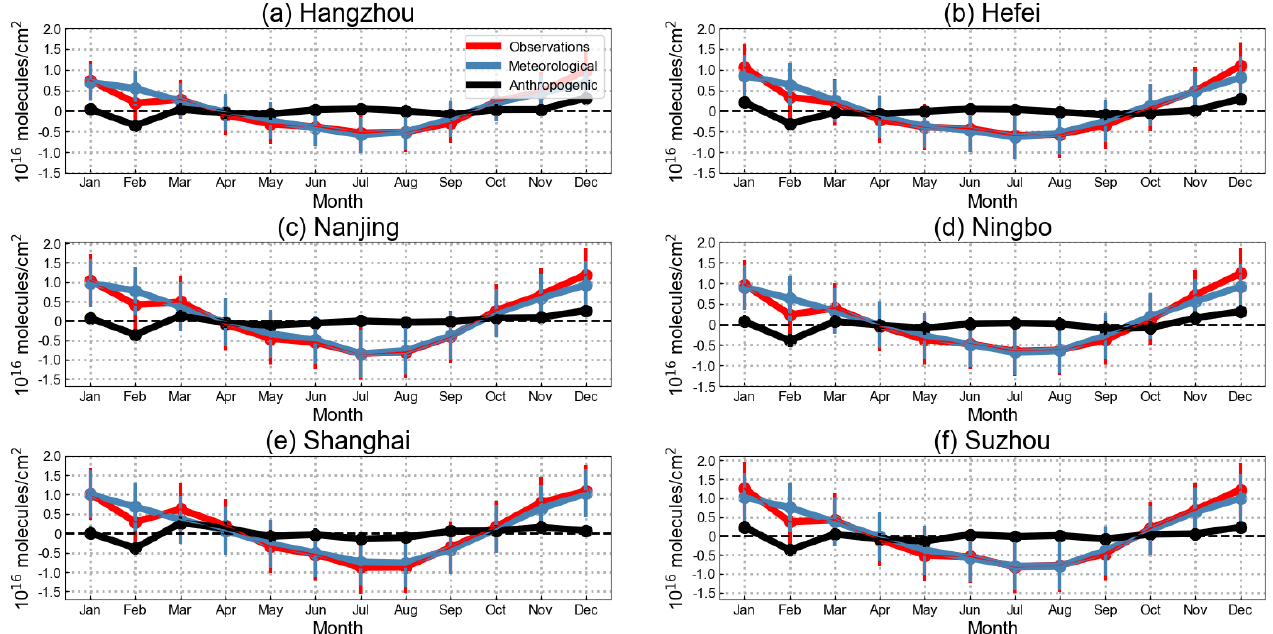
Figure 6. Monthly averaged NO 2 VCD trop (red dots and lines) along with the meteorological-driven portions (blue dots and lines) and the anthropogenic-driven portions (black dots and lines) over each city within the YRD. The vertical error bar is 1 σ standard deviation (SD) within that